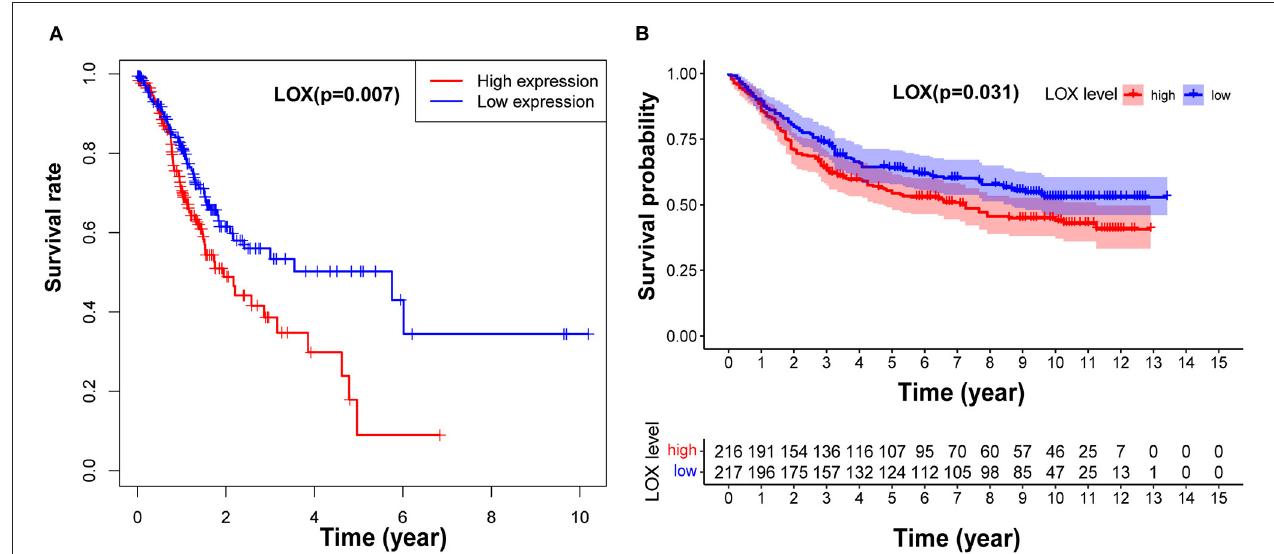
FIGURE 2 | LOX impact on the overall survival of patients with GC. (A) Kaplan-Meier curve was used to analyze the relationship between LOX mRNA expression and prognosis of GC patients based on TCGA data ( p = 0.007). (B) Kaplan-Meier curve was used to analyze the relationship between LOX mRNA expression and prognosis of GC patients based on GEO data ( p = 0.031). TCGA, The Cancer Genome Atlas; GEO, the Gene Expression Omnibus.